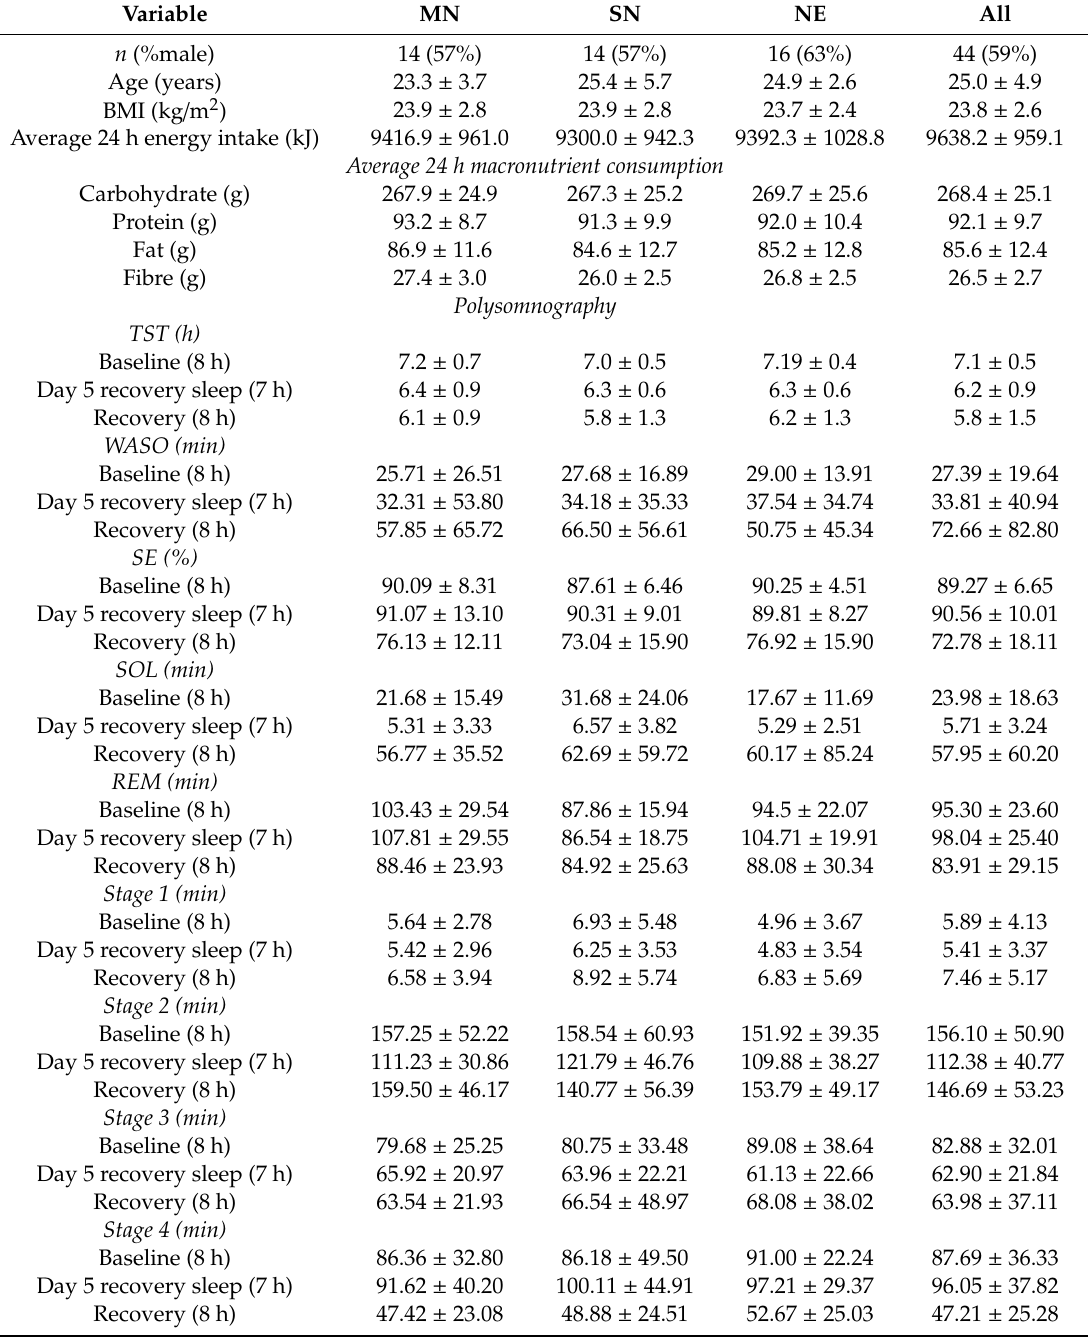
Table 2. Participantsex, age, BMI,average24henergyintake, andaverage24hmacronutrientconsumption. Variable MN SN NE